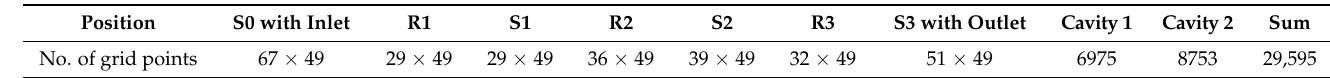
Table 3. Number of grid points of configuration